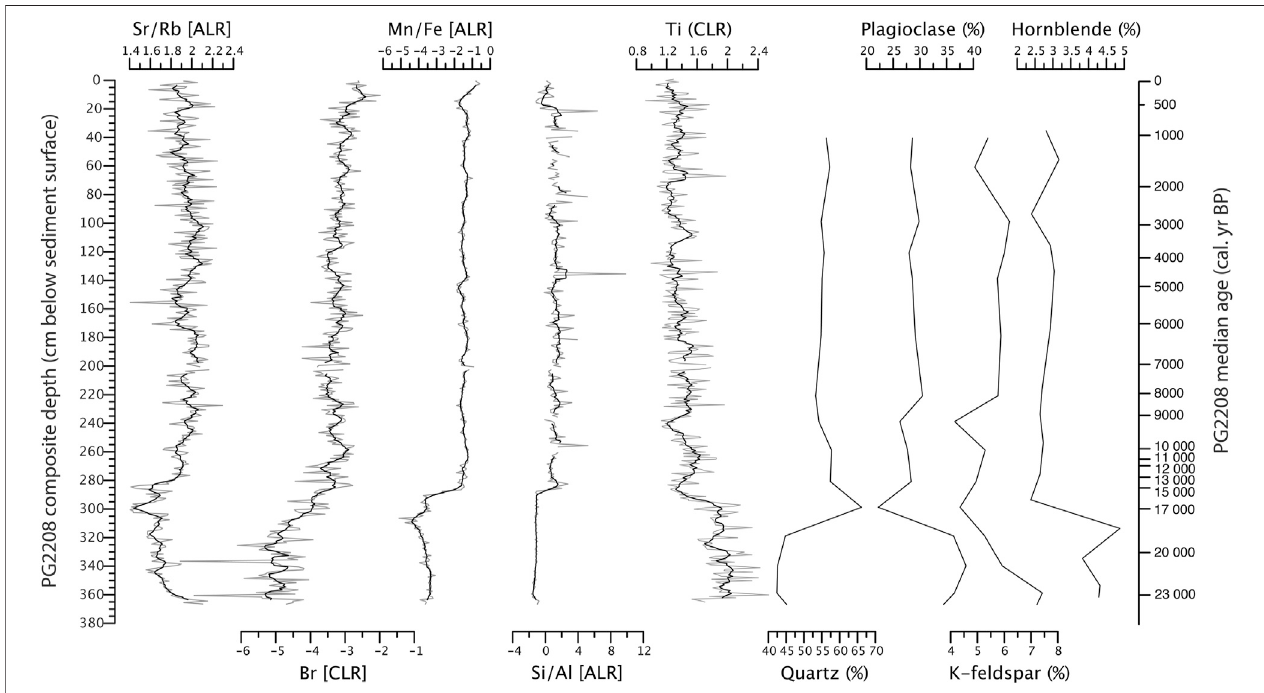
FIGURE 4 | Sediment-geochemical downcore variability in Bolshoe Toko (sediment core PG2208). Elemental data from XRF scanning given as additive log ratios (ALR) or centered log ratios (CLR) with 5-point running averages (black lines). Mineral data from XRD given as semi-quantitative percentage data.